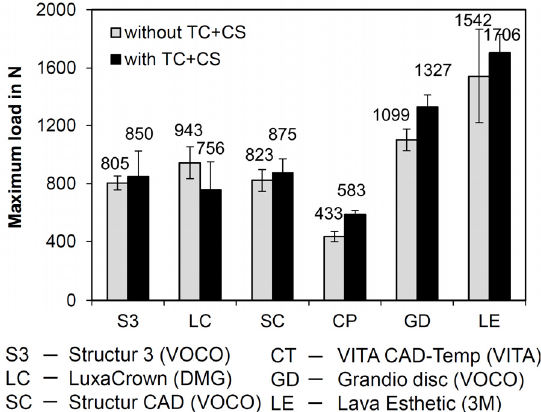
Figure 2. Failure loads without (10 samples per material) and after simultaneous chewing simulation and thermocycling (CS + TC) (8 samples per material; exception: S3; only four FDPs were forwarded to fracture analysis due to a 50% failure rate in chewing simulation).